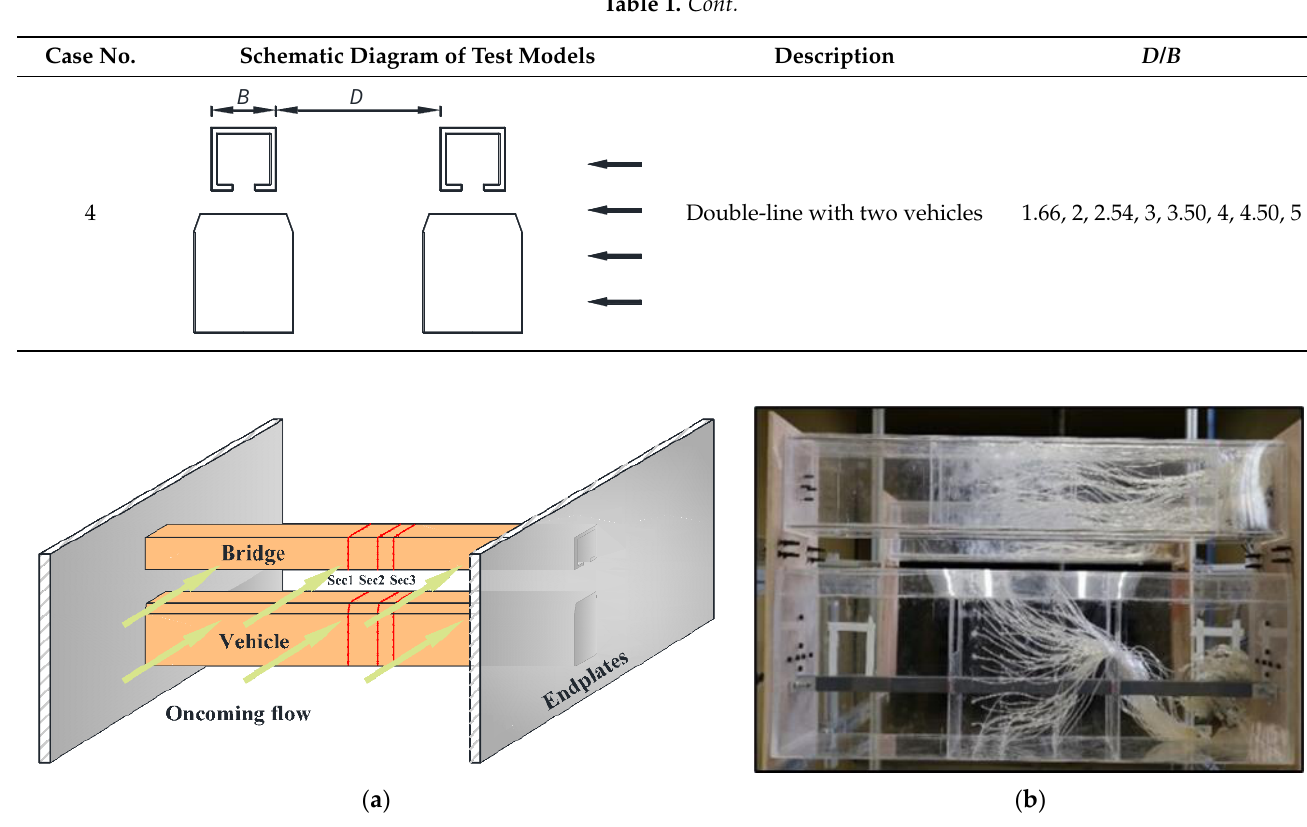
Figure 5. Models tested in the wind tunnel: ( a ) Design drawing; ( b ) Measured drawing.